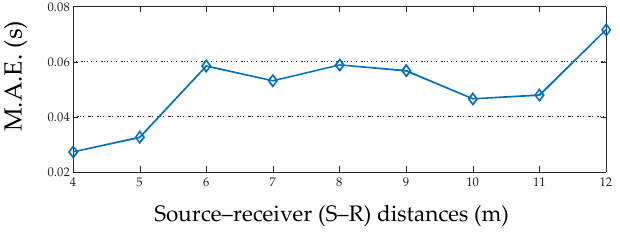
Figure 12. Mean absolute error among octave bands of T 20 among measurements with a dodecahedron speaker and a handclap as a sound source for different source–receiver distances.